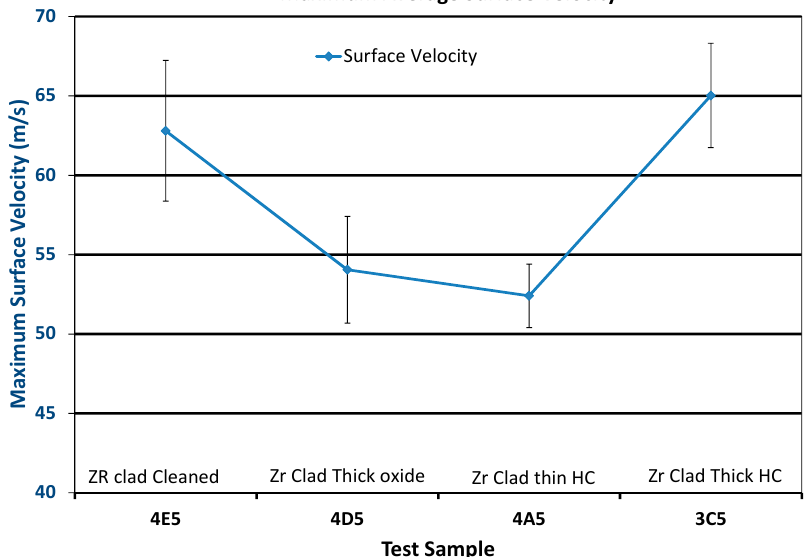
Figure 7. This graph shows the measured maximum surface velocity measured in the various Los Alamos National Laboratory (LANL) interface samples with varying levels of contamination.